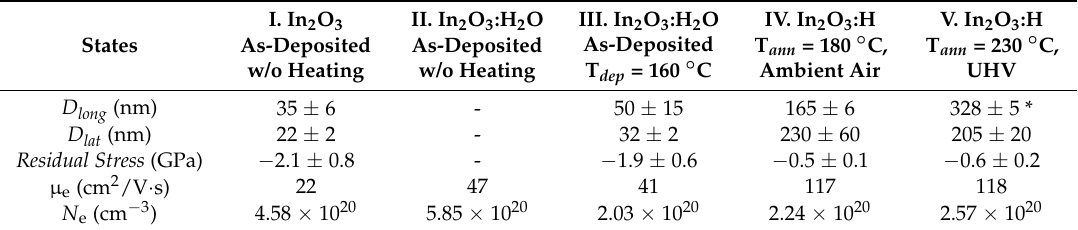
Table 1. Results of the XRD analysis and electron Hall-mobility data for the differently prepared ~150 nm thick In 2 O 3 films on glass. The Roman numerals are used in the text for easier distinction of the film